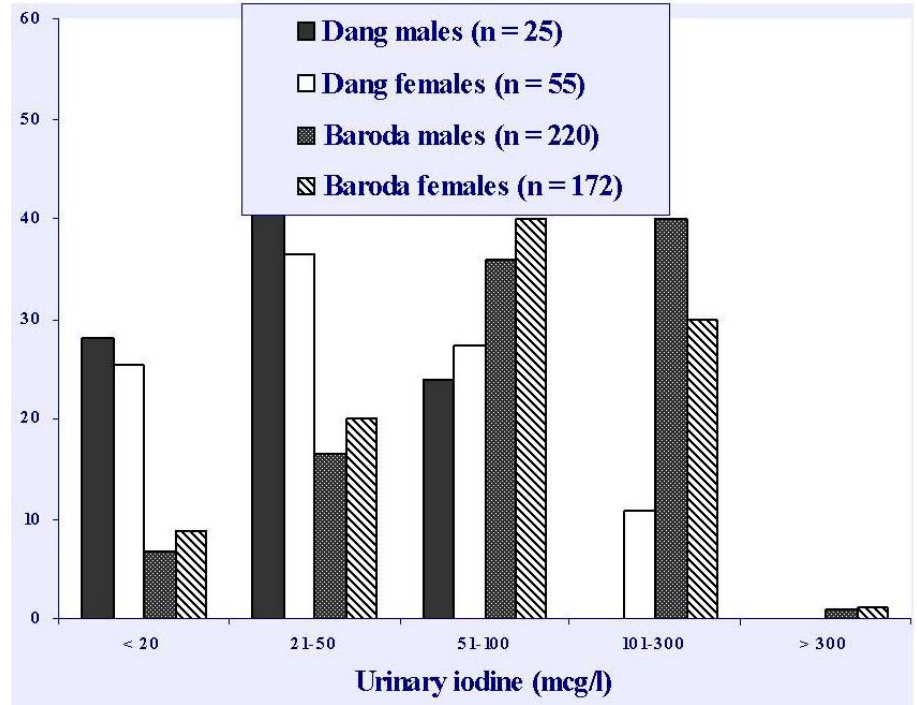
FIGURE 1. Frequency distribution of urinary iodine ( µ g/l) by gender and district in Gujarati adults (n =